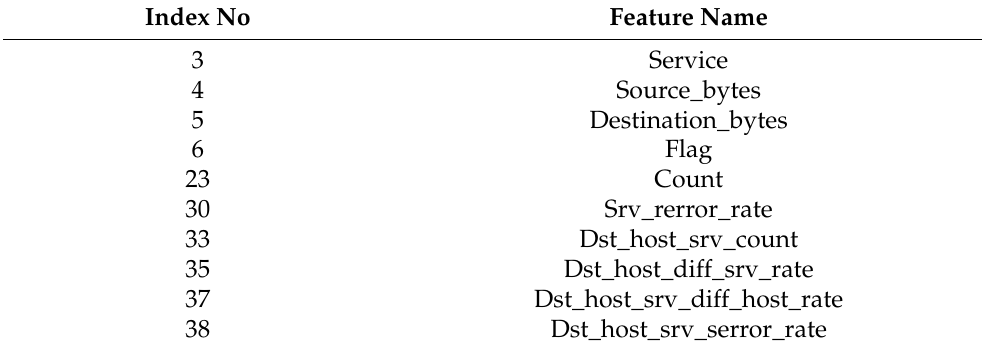
Table 3. Identified features for NSL-KDD